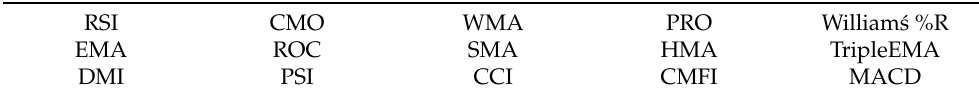
Table 2. List of 15 technical